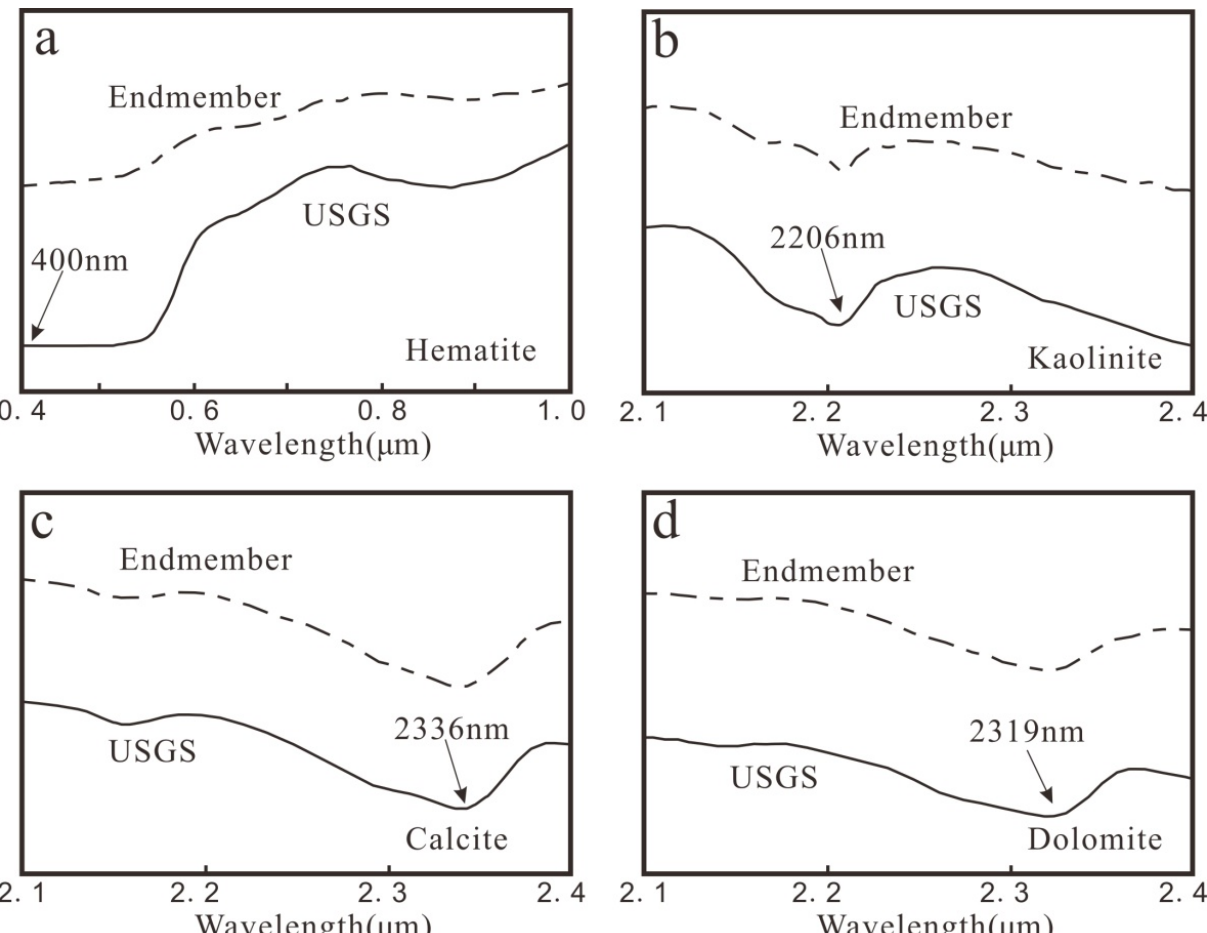
Figure 7. The reflectance spectral curves of the endmembers extracted from GF-5 hyperspectral data and of the endmembers derived from USGS spectral library version 7. ( a ) Hematite; ( b ) kaolinite; ( c ) calcite; ( d ) dolomite.